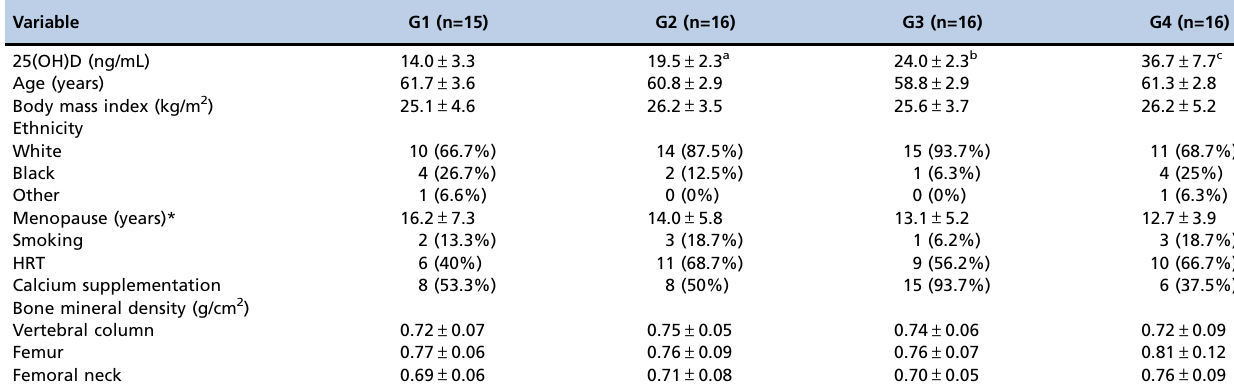
Table 2 - Demographic and clinical characteristics of the study participants in each group